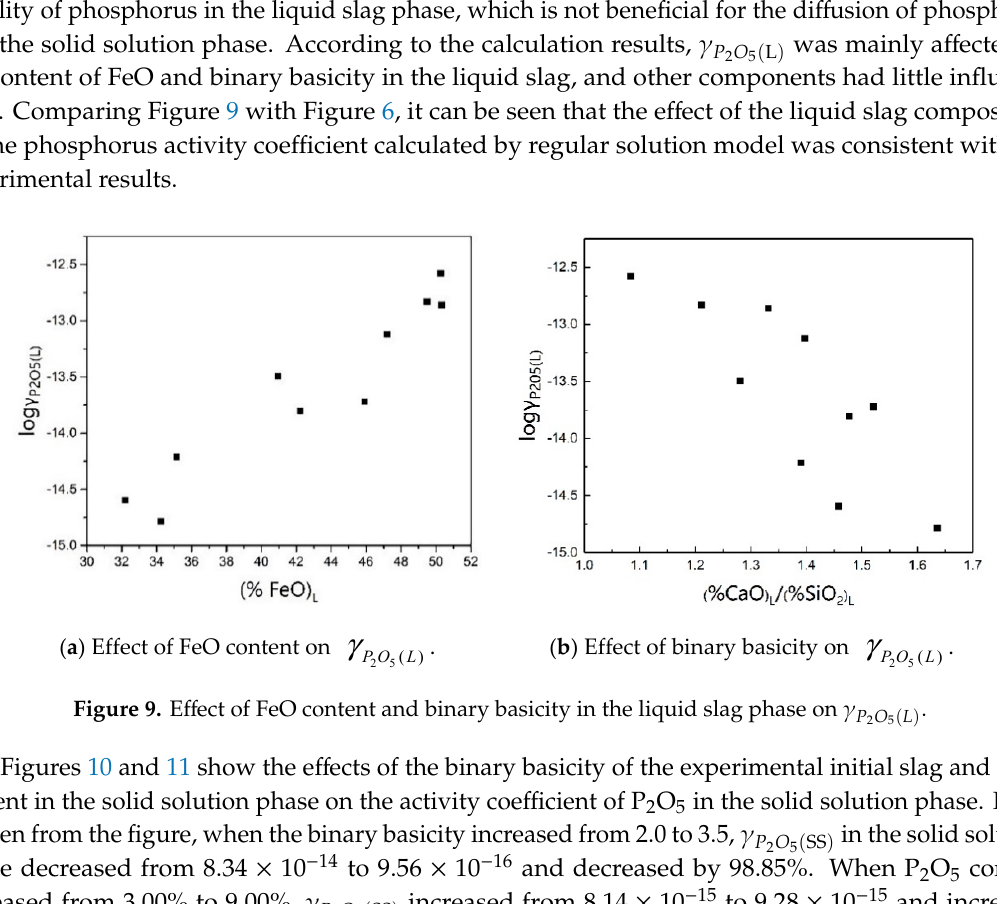
Figure 9. Effect of FeO content and binary basicity in the liquid slag phase on γ P